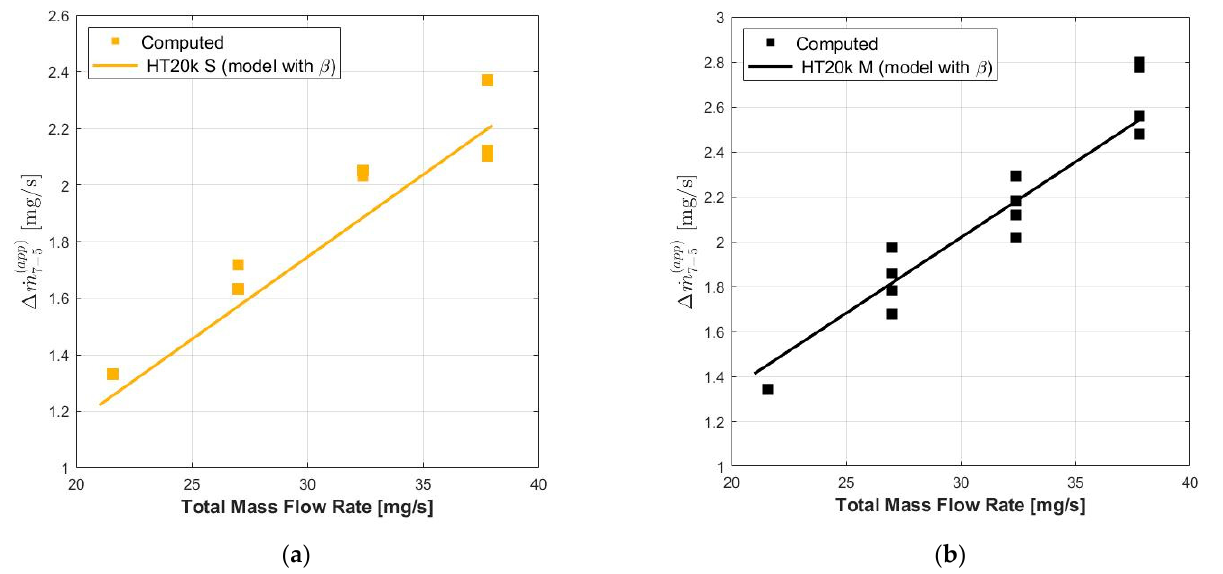
. ( app ) m 7 − 5 calculted for the thrust variations and